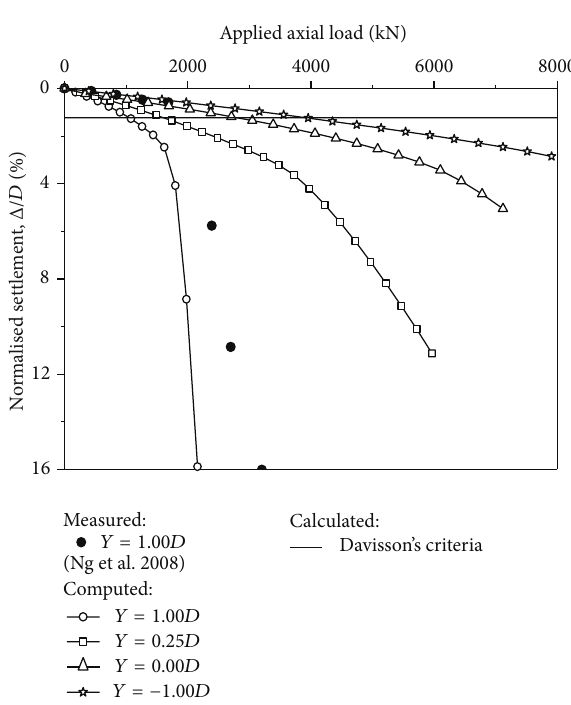
Figure 7: Measured and computed pile head settlement due to axial